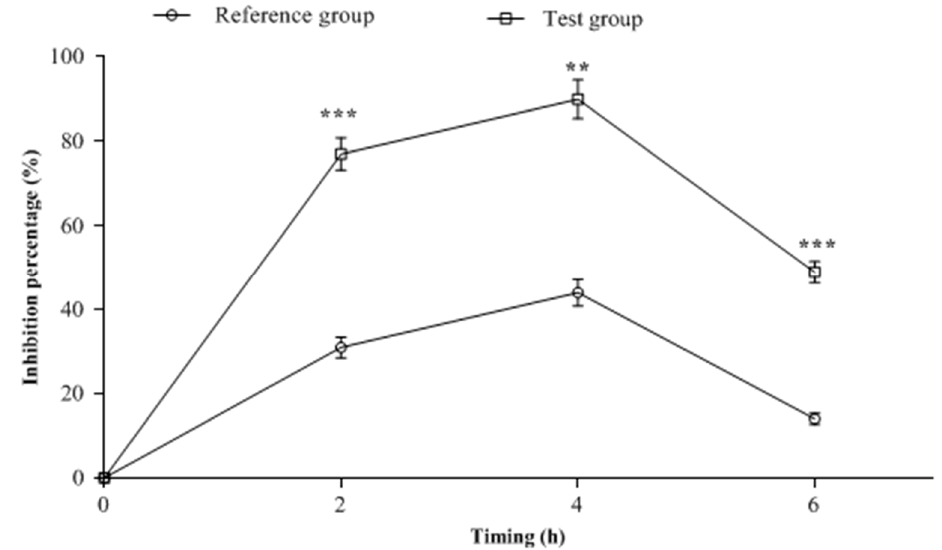
Figure 4. Effects of cerebrospinal fluid (CSF) samples collected from animals treated with AMX/Clav (reference group) or with AMX/Clav/1,8-cineole (test group) against E. coli ESBL-producing strain growth (inhibition%). **: statistically significant difference compared to reference group ( p < 0.01); ***: statistically significant difference compared to reference group ( p < 0.001).